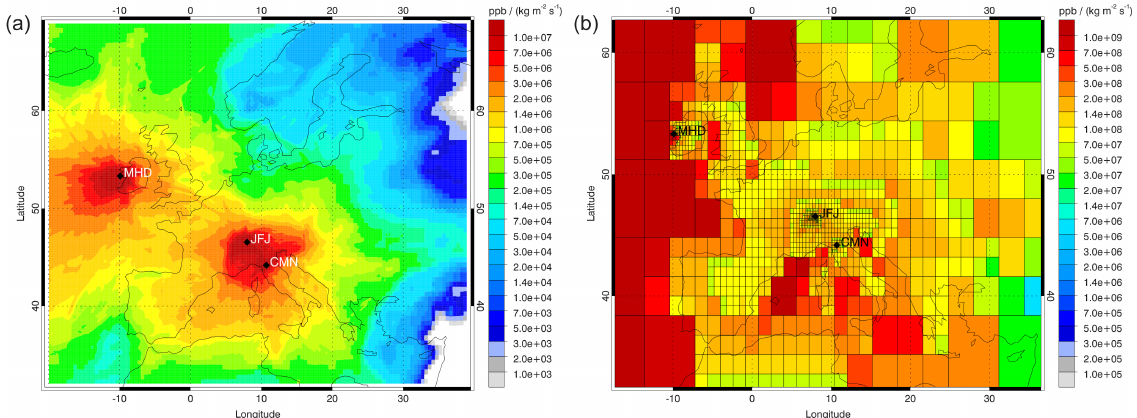
Figure 1. Annual mean surface sensitivity (ppb per kgm − 2 s − 1 ) for (a) the original 0.1 ◦ × 0.1 ◦ grid and (b) for the reduced grid of the FLEXPART-based model system